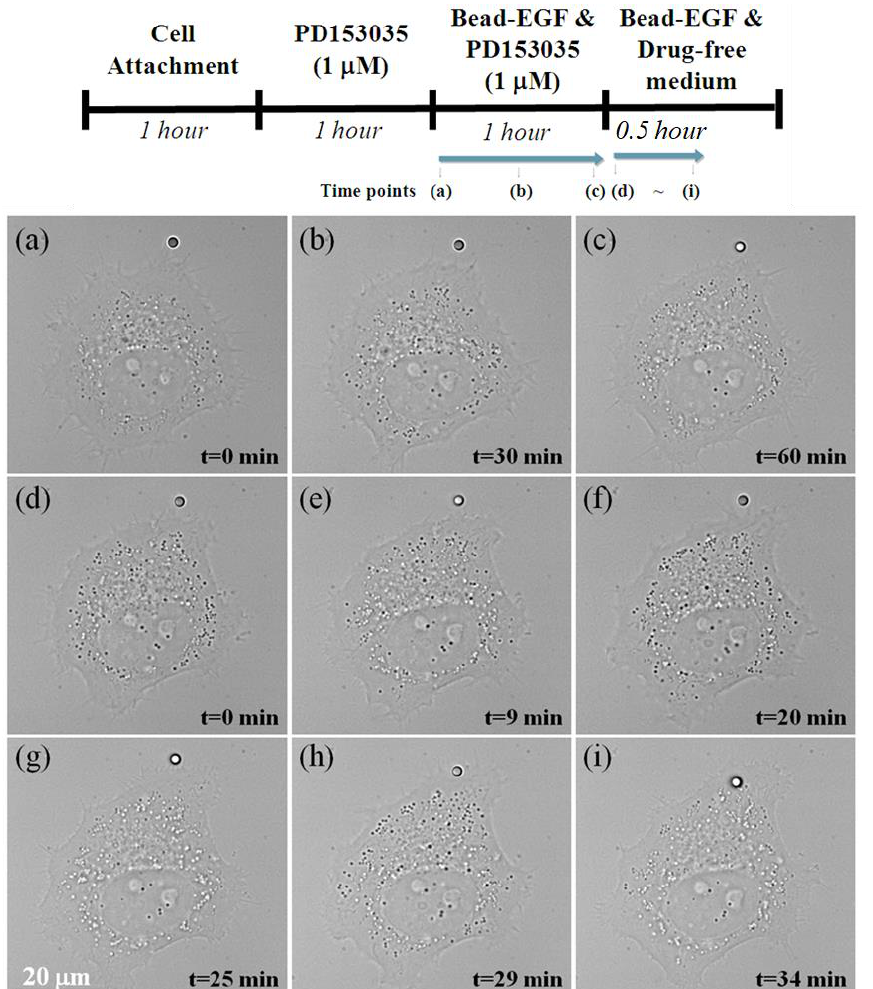
Figure 7. Probing the effect of PD153035 on the mode of locomotion during EGF-coated bead stimulation. ( a – c ) The simultaneous bright-field live HT29 cell imaging in the presence of 1 μ M of PD153035 for 1 h at 37 °C. ( d – i ) After washing the HT29 cells with drug-free medium, the simultaneous bright-field imaging of the same live HT29 cell was observed at 37 °C within 1 h.